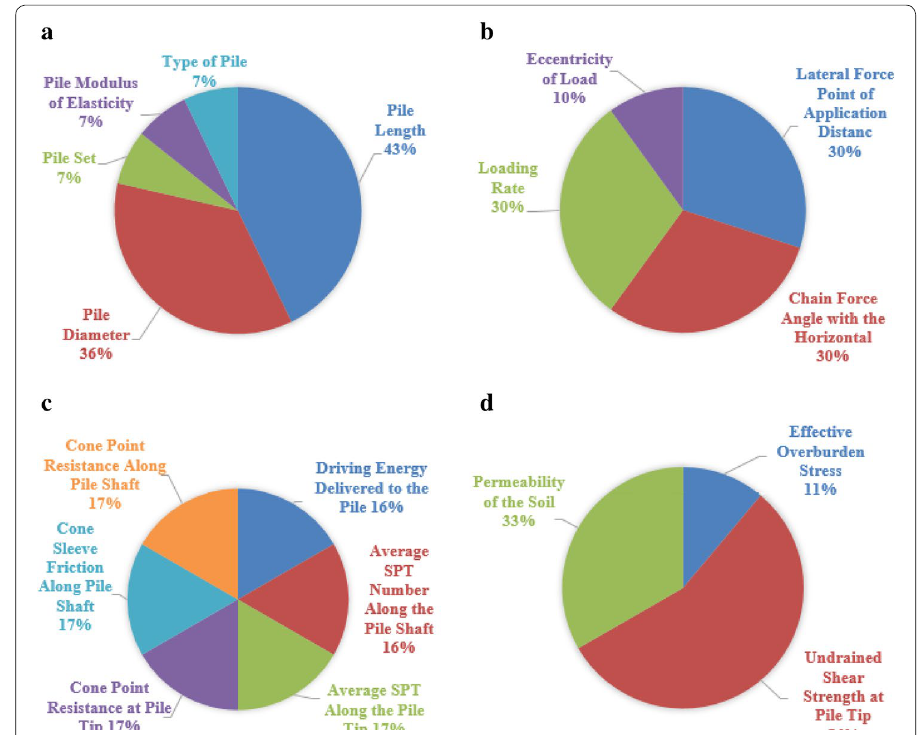
Fig. 7 Percentage of repeat of input variables in GP applications for ( a ) pile properties, ( b ) loading history, ( c ) hammer/SPT/CPT information, and ( d ) soil properties